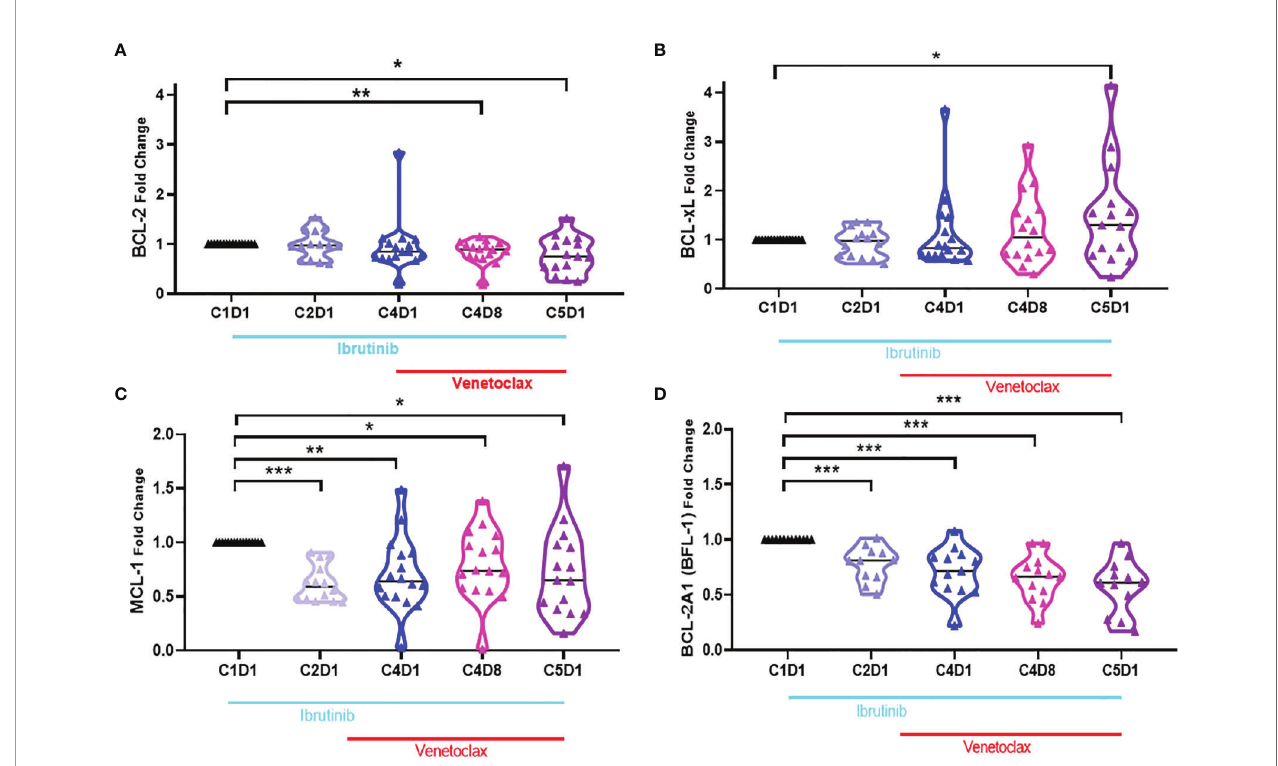
FIGURE 5 | Violin plots for changes in the level of Bcl-2 antiapoptotic proteins during ibrutinib monotherapy or ibrutinib plus venetoclax therapy. PBMCs from 13 to 15 patients were obtained at indicated times during therapy. Proteins were extracted and immunoblots were performed for Bcl-2 (A) , Bcl-xL (B) , Mcl-1 (C) , and Bcl2A1 (D) . . Protein levels were quantitated and normalized with GAPDH and compared with the levels at baseline (C1D1). C, cycle and D, days. Statistical signi fi cance between any time points and baseline values is provided. * ≤ 0.05; ** ≤ 0.001; *** ≤